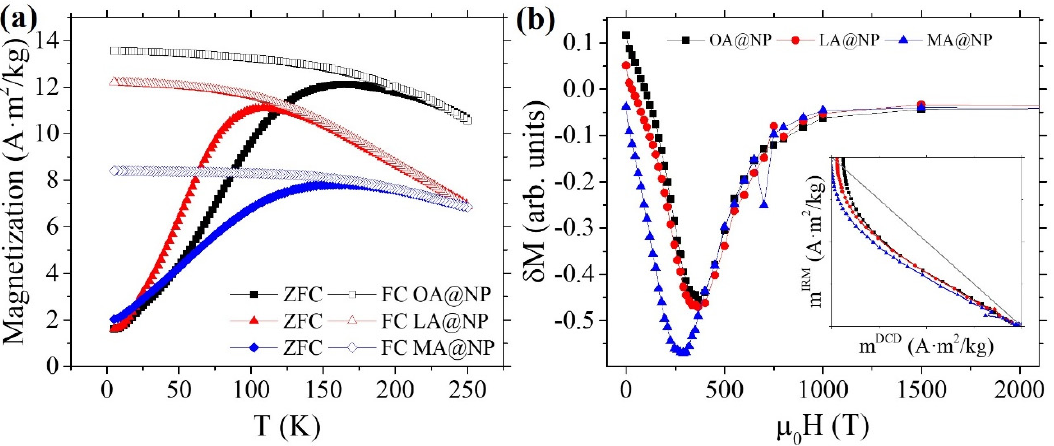
Figure 4. ( a ) ZFC–FC curves of the three samples. ( b ) δ M curves calculated from m IRM and m DCD curves measured at 5 K. The inset graph shows the Henkel Plots for the three samples OA@NP, LA@NP, and MA@NP.